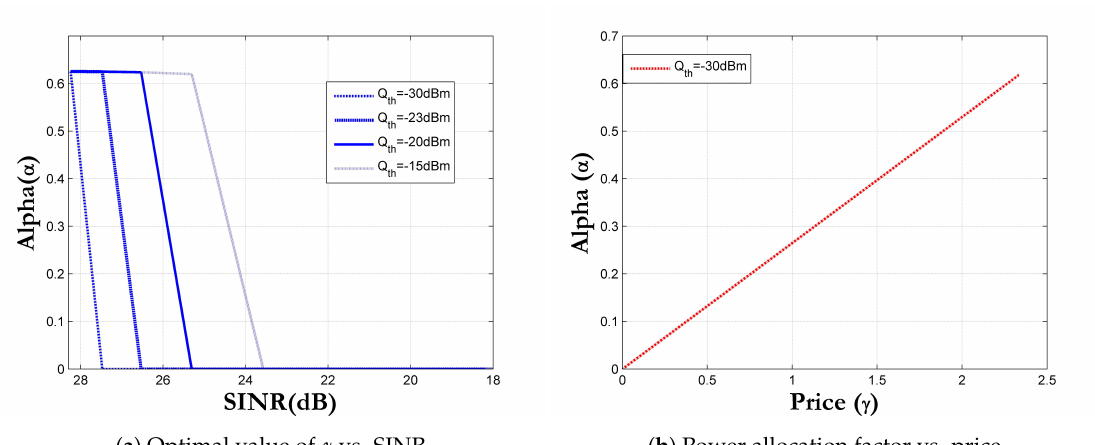
Figure 3. Optimal value of power allocation factor α and its relationship with price γ .